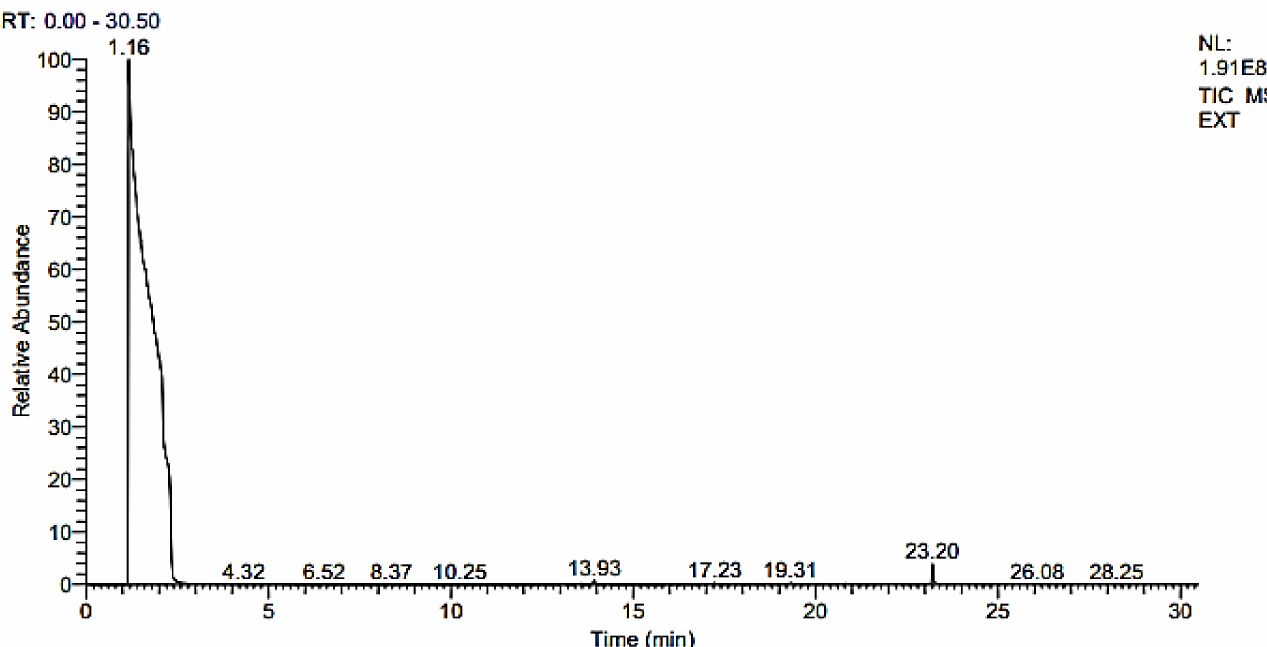
Figure 3. GC chromatogram of Indigofera linifolia leaves